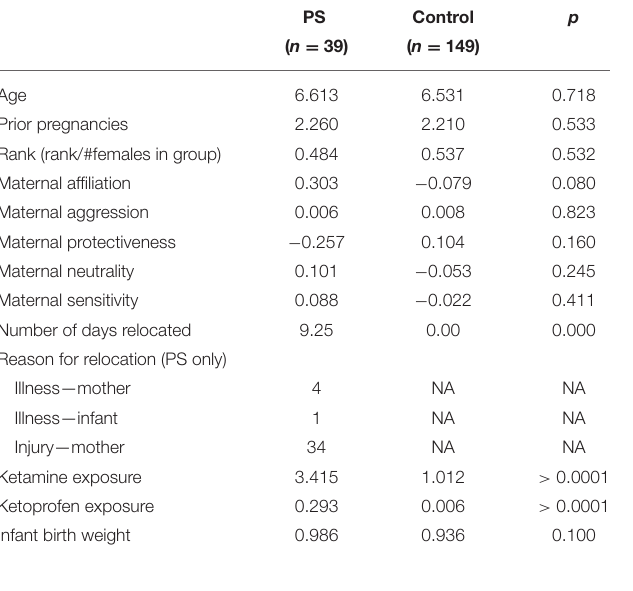
TABLE 1 | Prenatal stress vs. control female demographics.